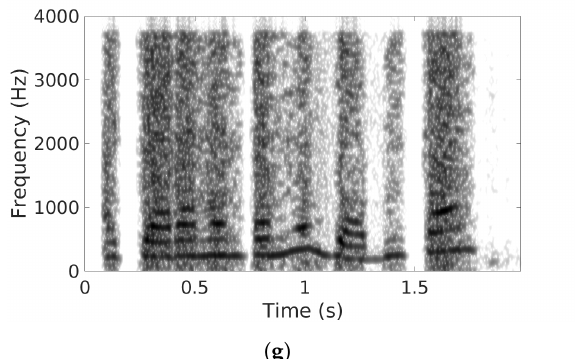
Figure 8. The spectrogram of female speakers: “acara nontonnya jadi kan” of ( a ) original speech, ( b ) the decrypted speech from GSM, the enhanced speech from ( c ) the Wiener filter, ( d ) KLT, ( e ) LogMMSE, and ( f ) NMF, and ( g ) the the proposed